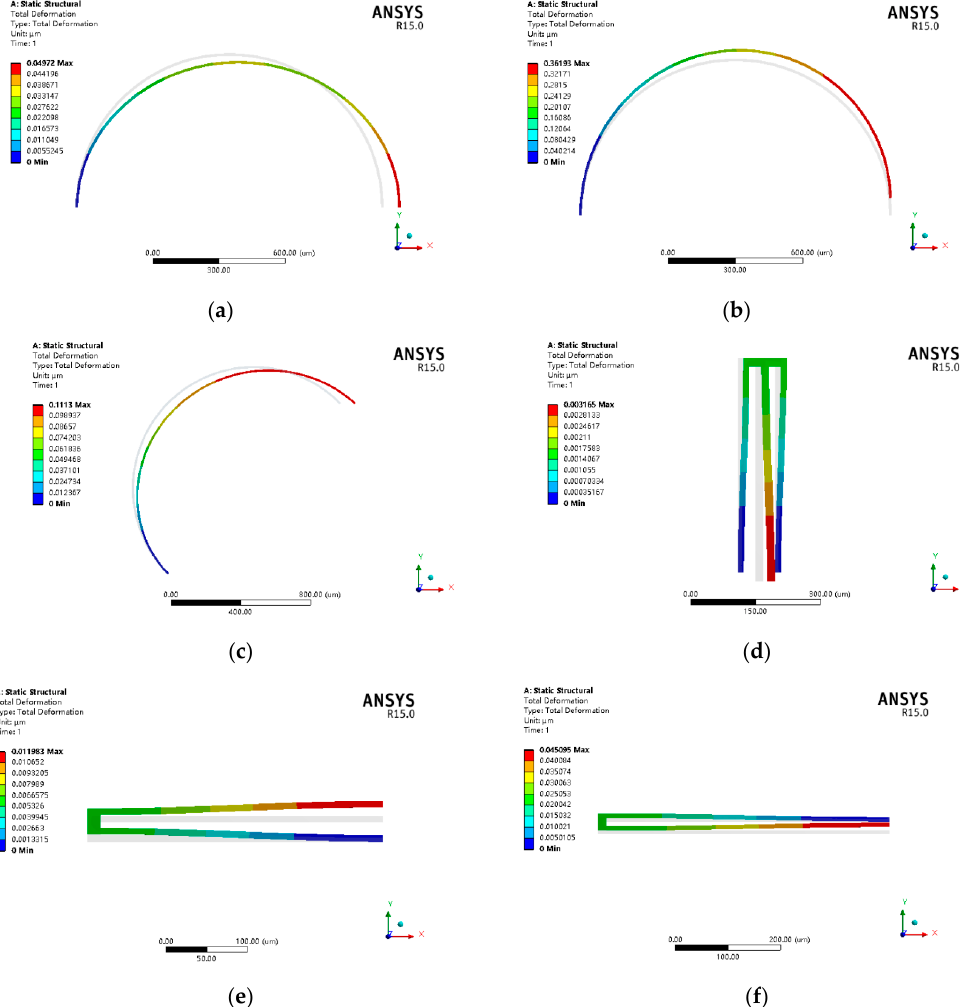
Figure 7. Sti ff ness of various beams of MEMS gyroscope: ( a ) deformation of K ns ; ( b ) deformation of Figure 7. Stiffness of various beams of MEMS gyroscope: ( a ) deformation of K ts ; ( c ) deformation of K 45 ; ( d ) deformation of K hx ; ( e ) deformation of K dsy 1 ; ( f ) deformation of K dsy 2 K ; ( c ) deformation of ts